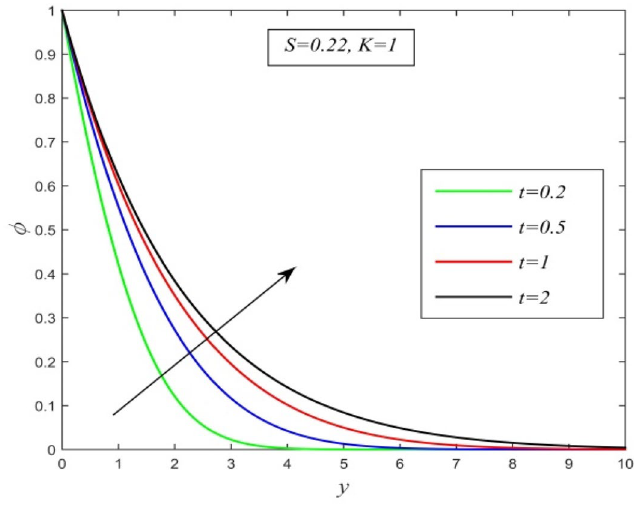
Figure 2. versus y for different t and Sc = 0.22, K = 1.